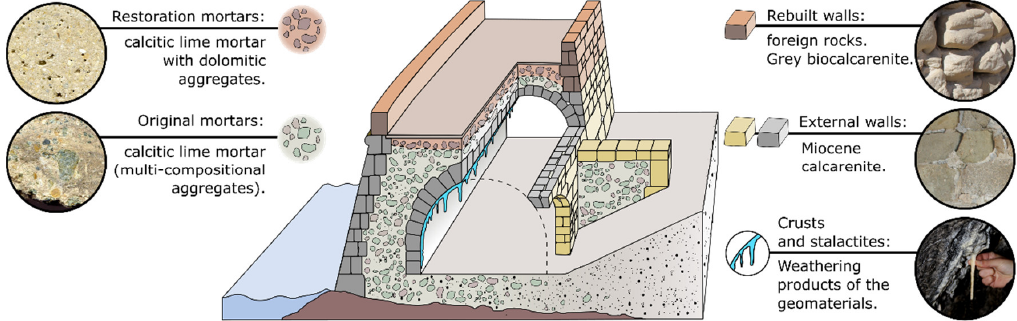
Figure 2. Constructive sketch of the city-wall of Nueva Tabarca showing the location of the studied vaulted storerooms and the used geomaterials of the building.